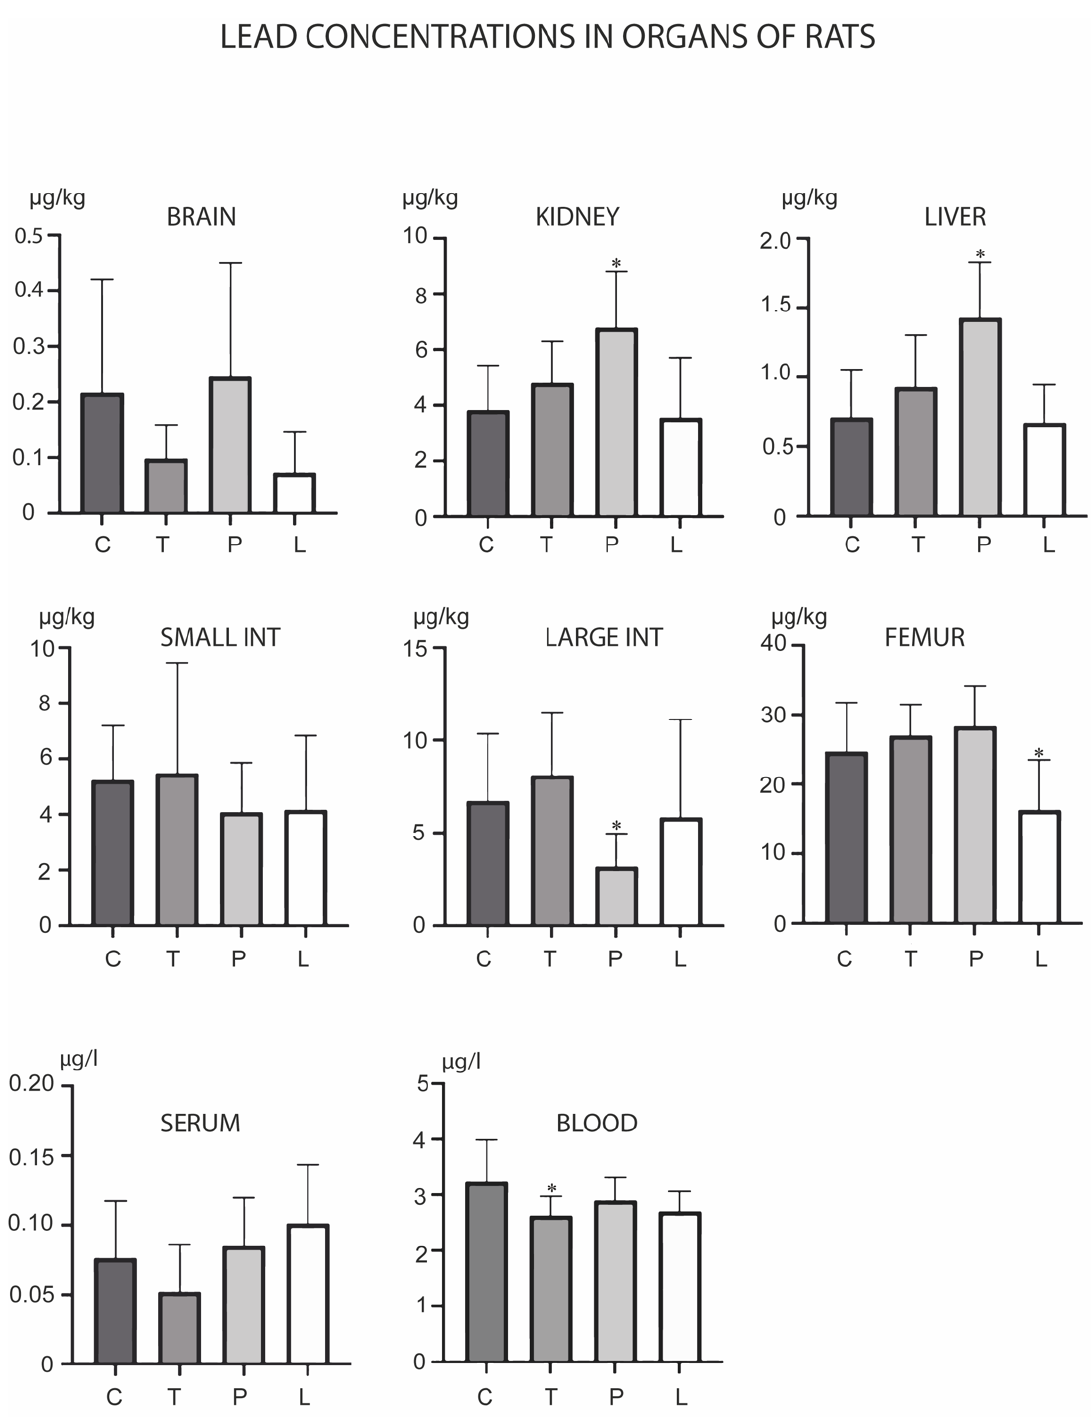
Figure 6. Concentrations of lead in the brain, kidney, liver, small intestine, large intestine, serum, blood and femur after the three-month oral administration of silicates. C denotes the control group; T denotes the experimental group receiving TMAZ; P denotes the experimental group receiving PMA; and L denotes the experimental group receiving Ludox silica. Asterisk (*) denotes significant differences between the experimental groups, with control at p < 0.05.